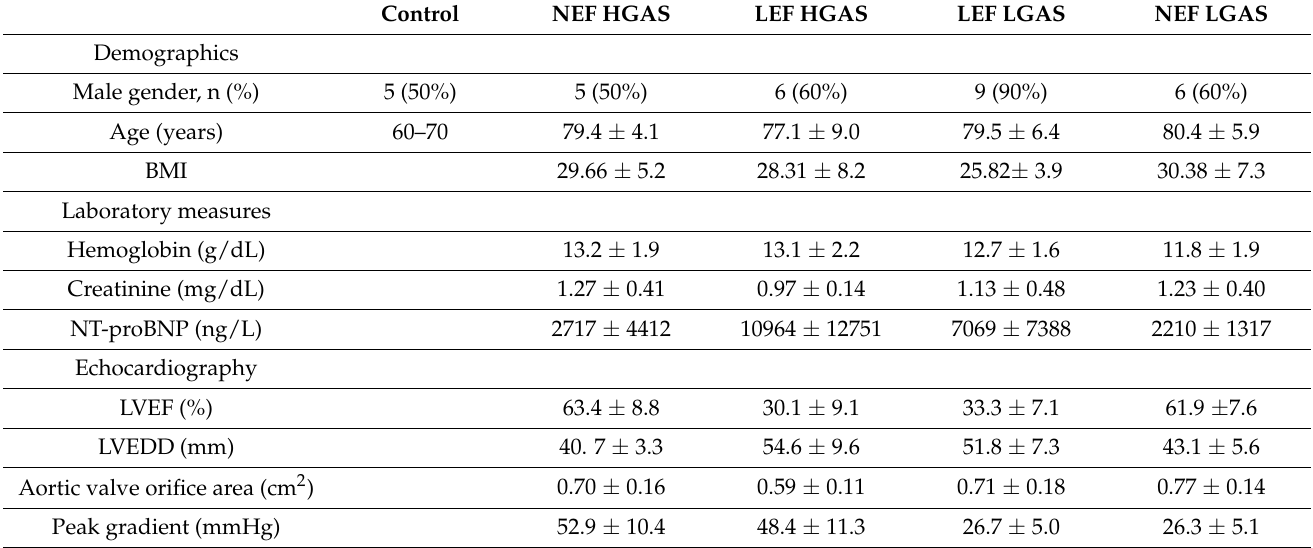
Table 2. Study participants’ characteristics. 40 patients prior to TAVR (10 patients per AS subgroup) and 10 healthy controls were included in this study. BMI: body mass index, LVEDD: left ventricular end-diastolic diameter. NEF HGAS LEF